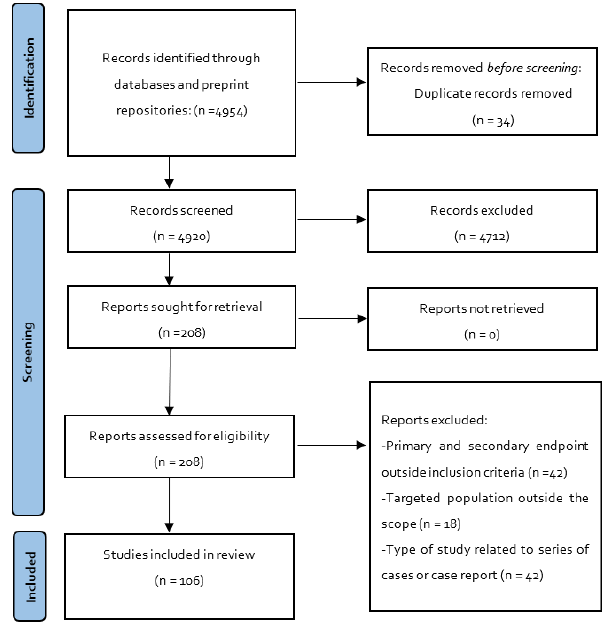
Figure 1. Flowchart of selected studies .